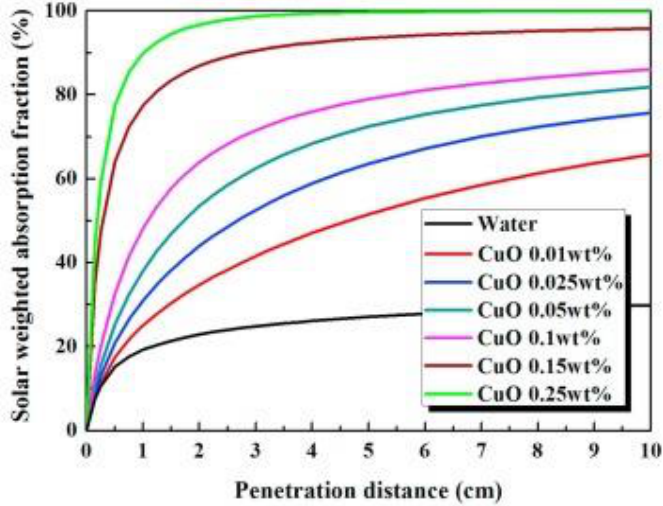
Figure 9. Solar weighted absorption fraction of CuO nanofluid with different nanofluid Solar weighted absorption fraction of CuO nanofluid with di ff erent nanofluid concentrations [27]; 2018, Elsevier. Energies 2020 , 13 , x FOR PEER REVIEW 11 of 34 concentrations [27]; 2018, Elsevier.